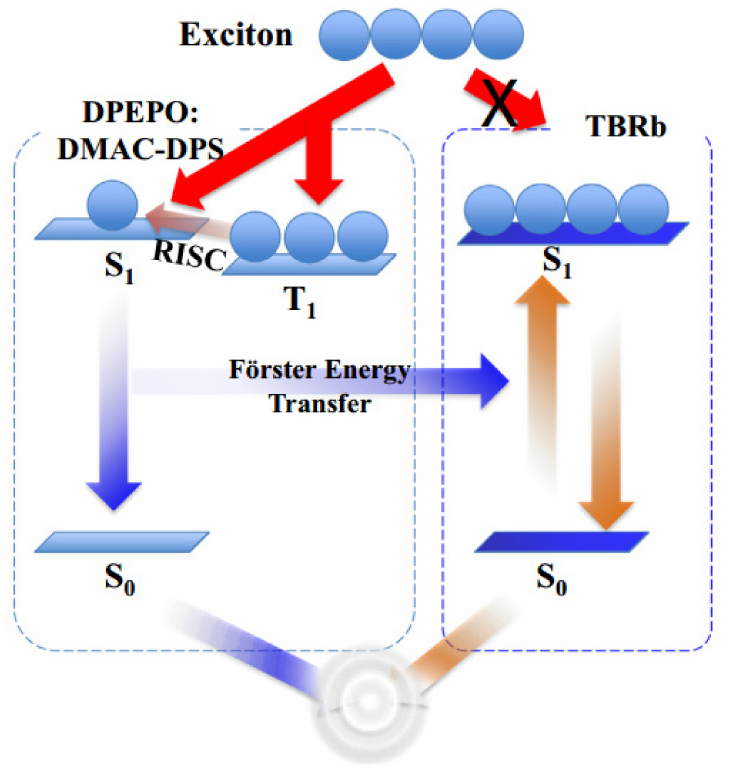
Figure 7. Schematic diagram showing the energy transfer process for maximum quantum efficiency. Reproduced with permission from [137], Elsevier,